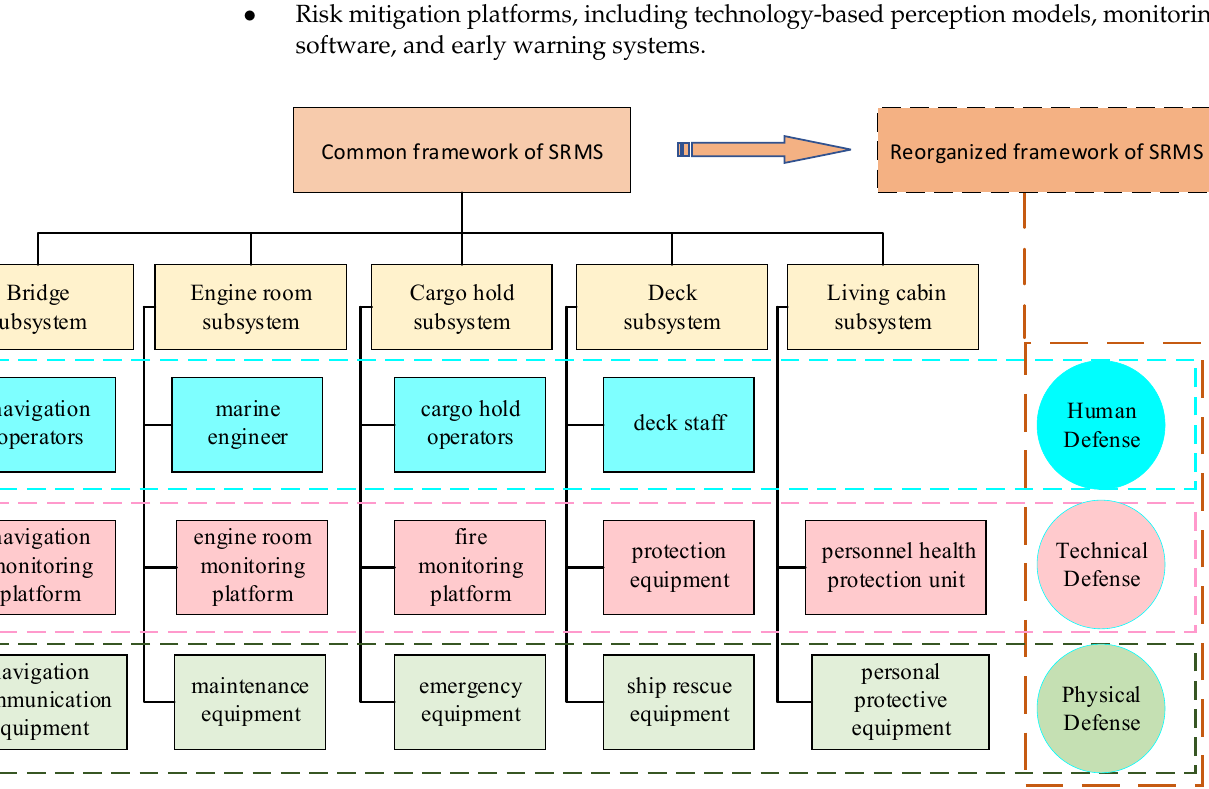
Figure 6. The common and reorganized framework of an SRMS.